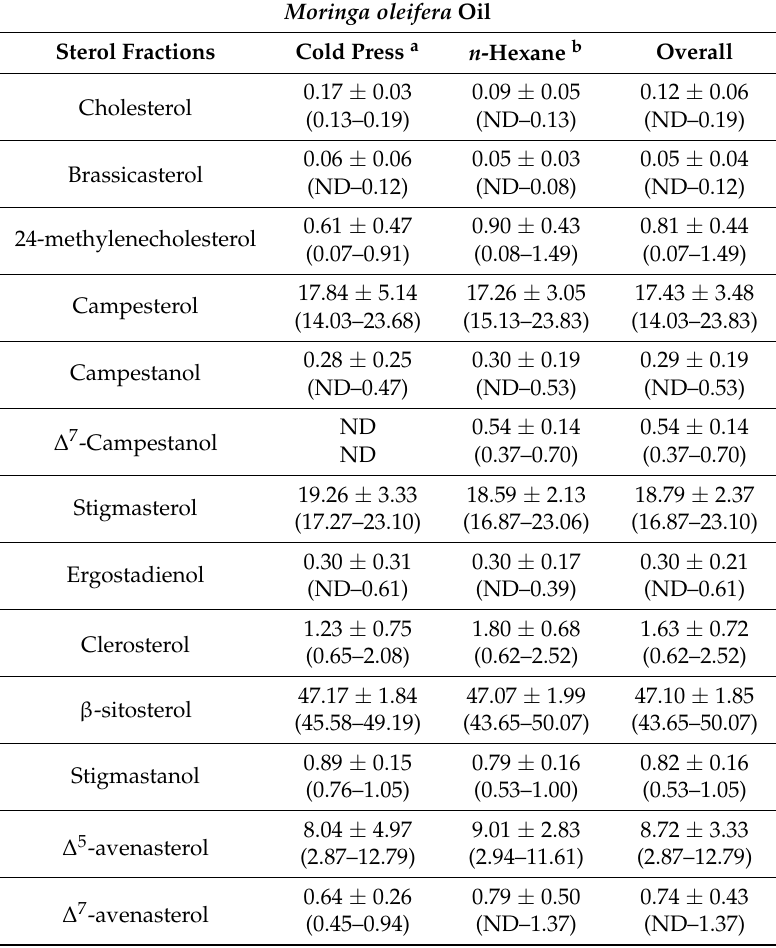
Table 4. Sterol composition of Moringa oleifera oil